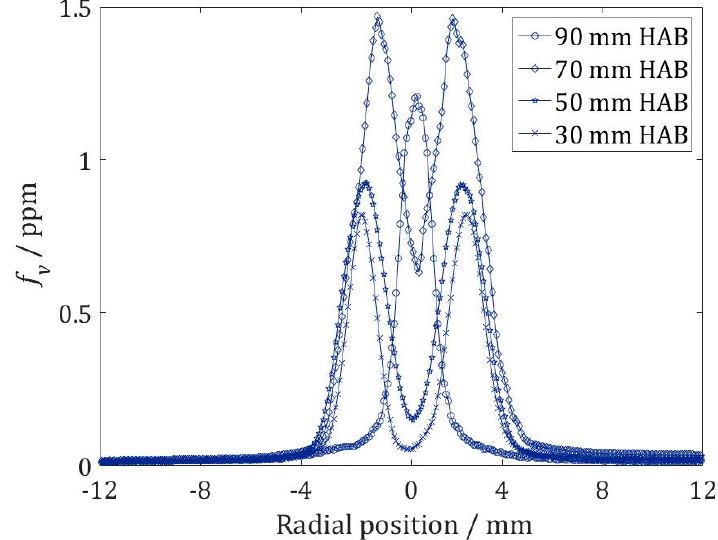
Figure 8. Comparison of soot volume fraction ( f v ) radial profiles at 30, 50, 70, and 90 mm for the reference diesel.